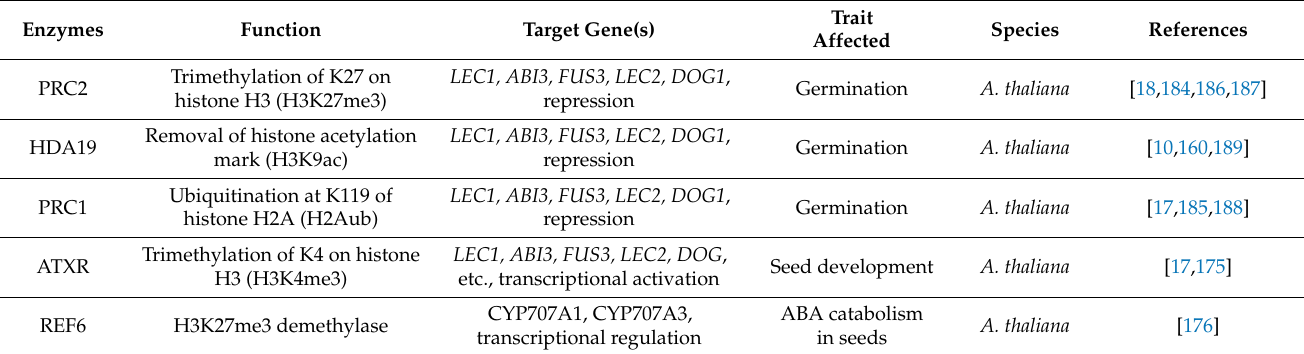
Table 1. A selected list of epigenetic modifications of histones involved in seed development and germination.